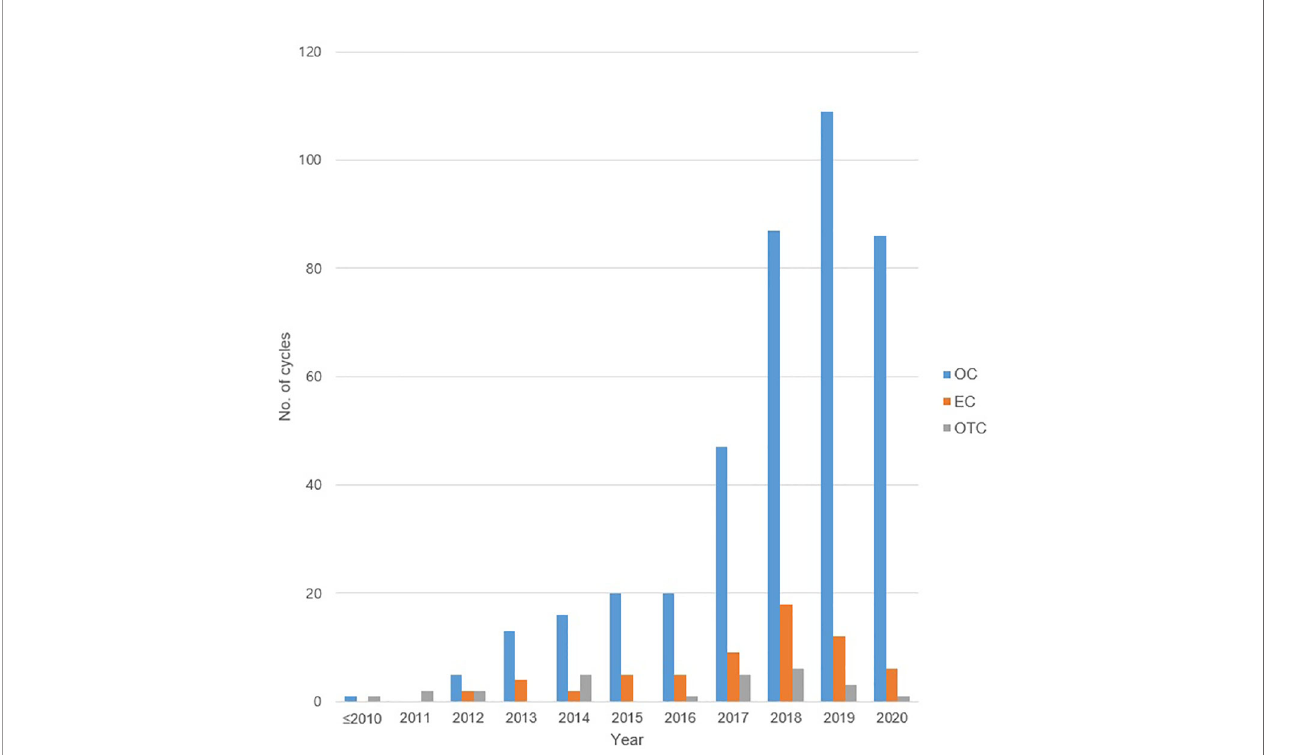
FIGURE 1 | The number of total oocyte cryopreservation, embryo cryopreservation cycles, and ovarian tissue cryopreservation by year. OC, oocyte cryopreservation; EC, embryo cryopreservation; OTC, ovarian tissue cryopreservation.